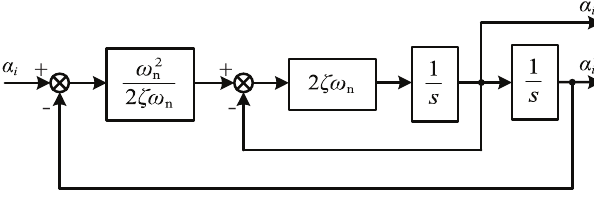
Figure 2. Structure of a second-order command